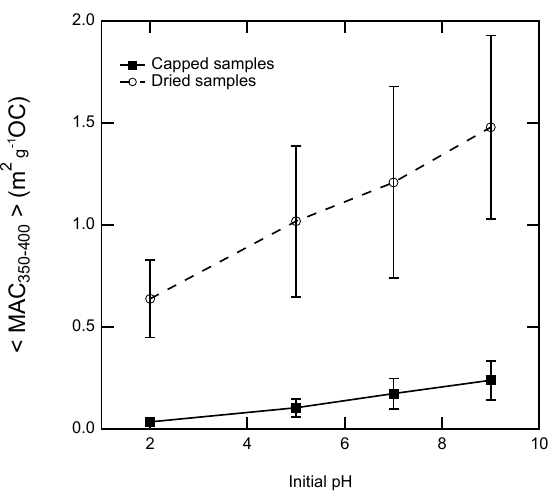
Figure 4. Solution-based mass absorption coefficients (MACs) cal- culated from 350–400nm as a function of initial solution pH for both capped and dried samples. While both capped and dried sam- ples become more absorptive in basic conditions, the pH depen- dence is more severe following evaporation to dryness. All samples in this table were analyzed after 7 days of